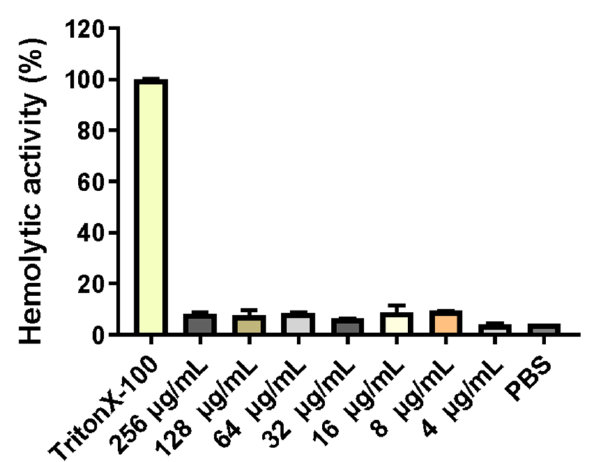
Figure 3. Hemolytic activity of recombinant of PNKL. PNKL 256 μg/mL PNKL, Triton X-100 0.1 % Triton X-100, PBS 10 Mm PBS (pH